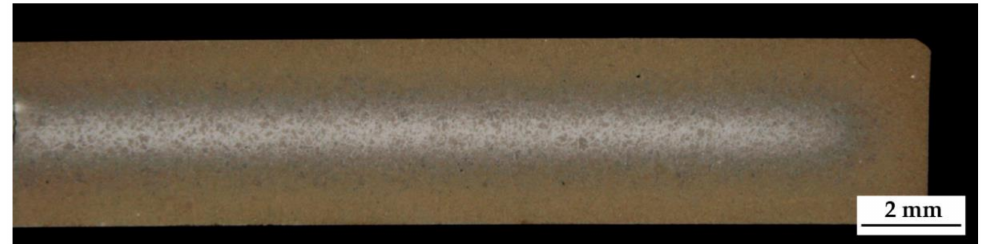
Figure 3. Macroscopic overview of the polished section of the carburized sample without hollow spheres. Color differences provide a visual idea of the hardening